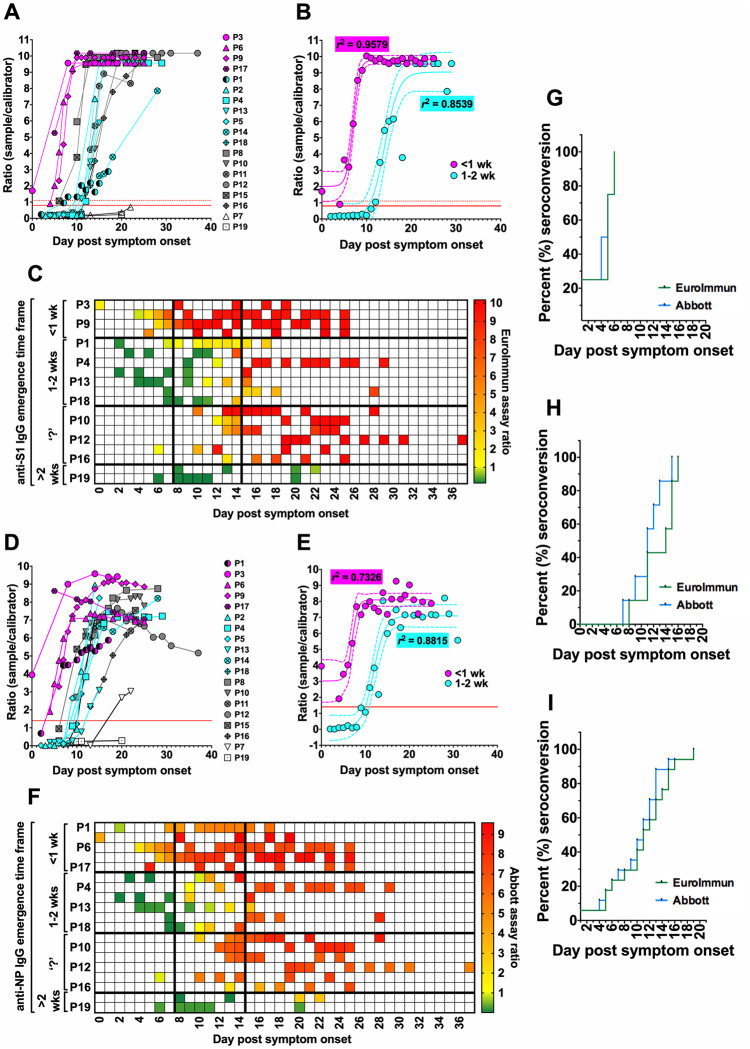
Temporal emergence of anti-S1 and anti-NP IgG amongst the cohort members.Serum samples collected from the cohort members over time were analysed for IgG against the major SARS-CoV-2 antigens. (A) Individual time course data for anti-S1 IgG emergence, and (B) best-fit curves for anti-S1 IgG responses occurring after < 7 days or between 7–14 days pso. Cut-offs for negative (ratio 0.8) and positive (ratio 1.1) seroreactivity in the EuroImmun assay are depicted by solid red line and dashed red line, respectively. (C) Data from A presented as a heat-map. (D—F) As in A-C, but for anti-NP IgG emergence. The cut-off (ratio 1.4) for negative/positive seroreactivity in the Abbott assay depicted in solid red line. Patient #1 was considered an outlier and was therefore excluded from all best-fit curve analyses. In B and E—dashed trend lines indicate 95% CI ranges; and r2 values describe tightness of fit. In C and E—‘?’ indicates undetermined seroconversion time frame. Kaplan-Meier curves comparing the seroconversion detection by the EuroImmun and Abbott assays amongst (G) the seroconverted, (H) those where seroconversion was observed, and (I) all cohort members combined.